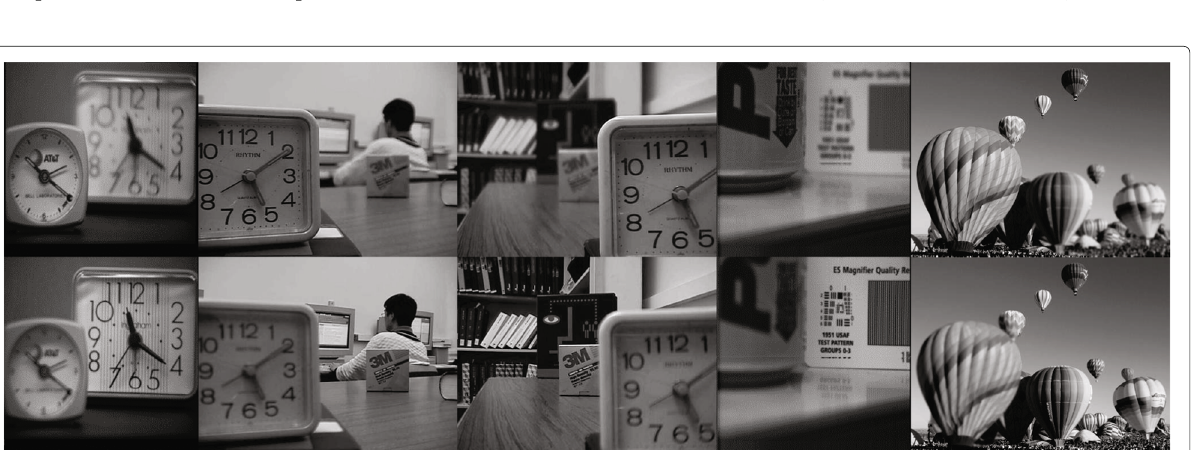
redundancy and imply that it is a potent signal process- ing tool. The LCWT-based denoising of chirp signals is investigated here to validate the theory proposed above.